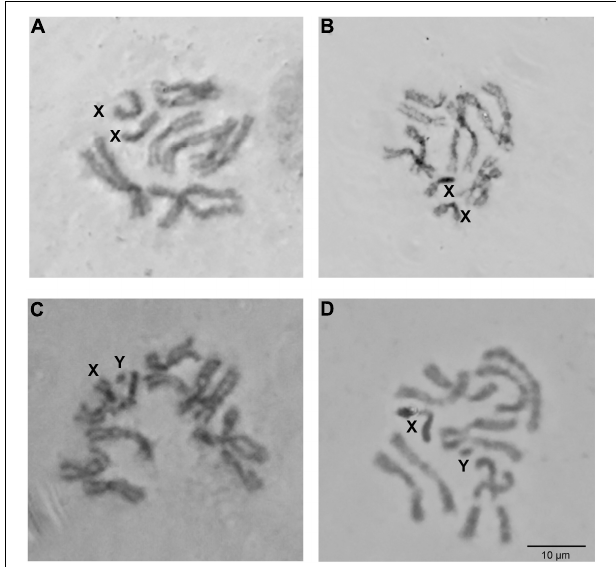
FIGURE 1 | Zeugodacus tau mitotic karyotype. Giemsa staining of mitotic metaphases from female (A,B) and male (C,D) larvae. X and Y chromosomes are